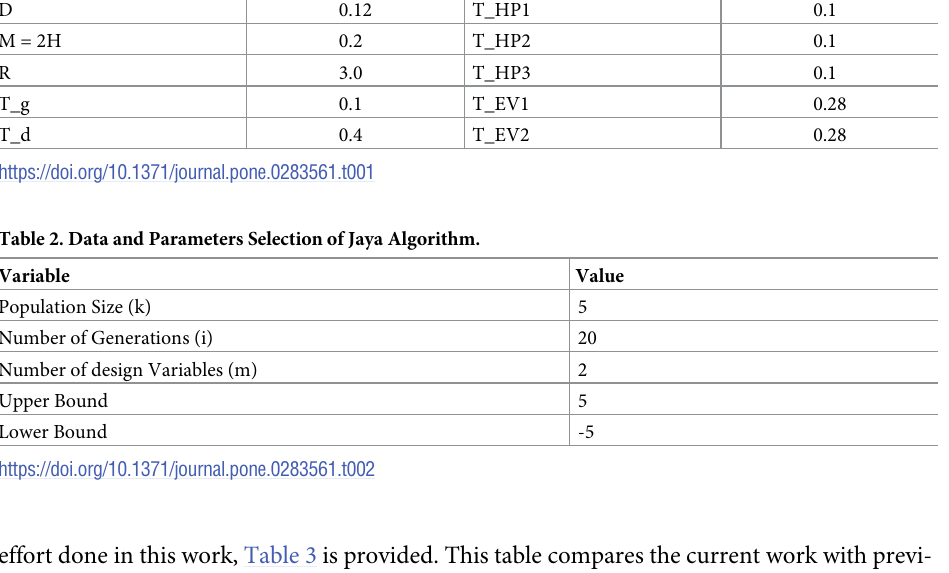
Table 1. Data and Parameters of the Suggested μ G. Parameter